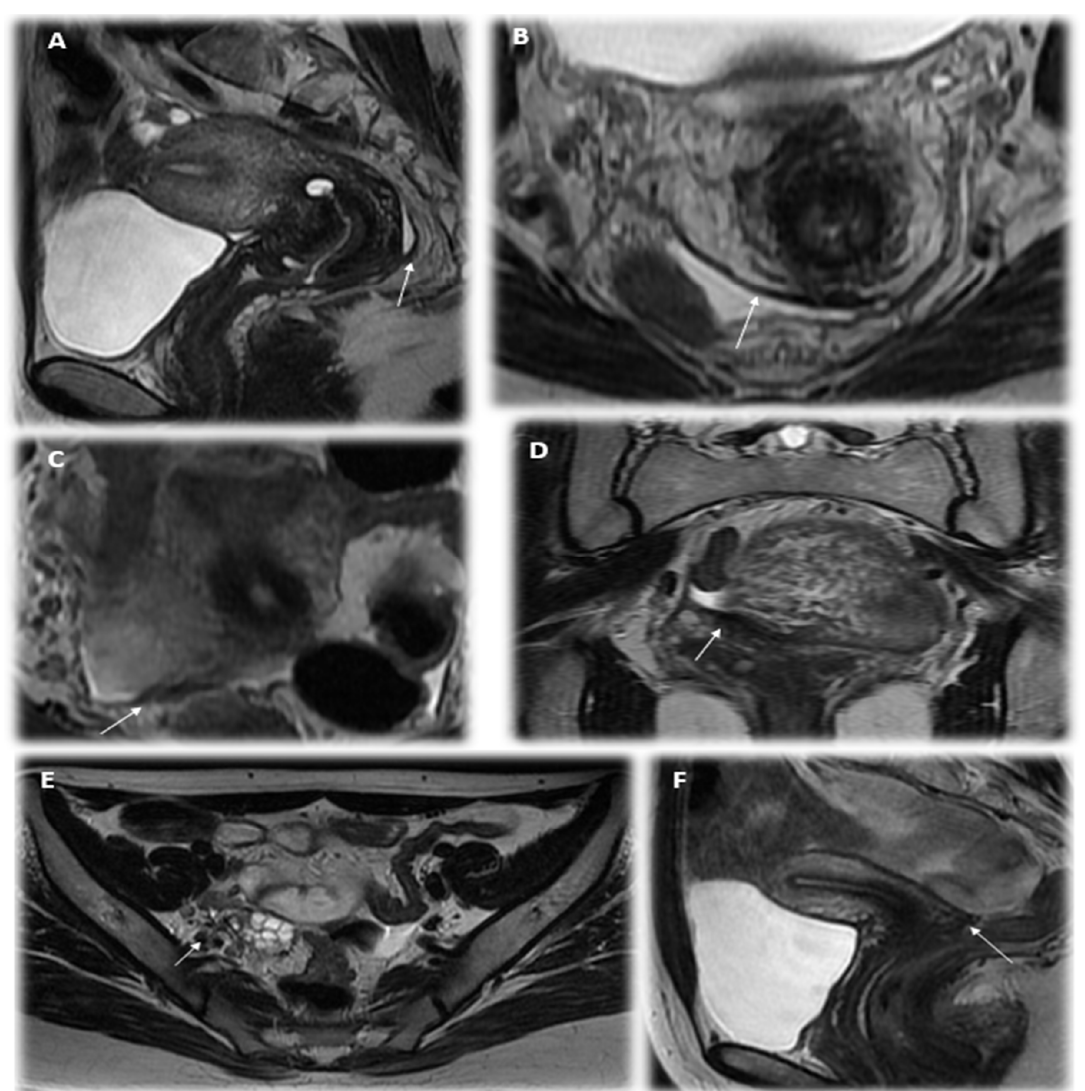
Figure 4. The MRI signs of peritoneal endometriosis in adolescents: ( A )—thickening of the perito- neum and partial obliteration of the pouch of Douglas (T2VI Sag); ( B )—thickening of the peritoneum of the Douglas space, free fluid and an area of low intensity of the MR signal in the projection of the uterosacral ligament on the left (T2VI Ax); ( C )—the thickening of the pelvic peritoneum and the uterosacral ligament on the right (T2VI Ax); ( D )—thickening of the peritoneum of the pelvic cavity and the right uterosacral ligament (T2WI Cor); ( E )—the asymmetry of the structure and hypointense MR signal in the projection of the sacro-uterine ligament on the right and fixation of the right ovary (T2VI Ax); ( F )—a single focus of a hypointense MR signal in the retrocervical space of small sizes (up to 0.3 cm) (T2VI Cor).